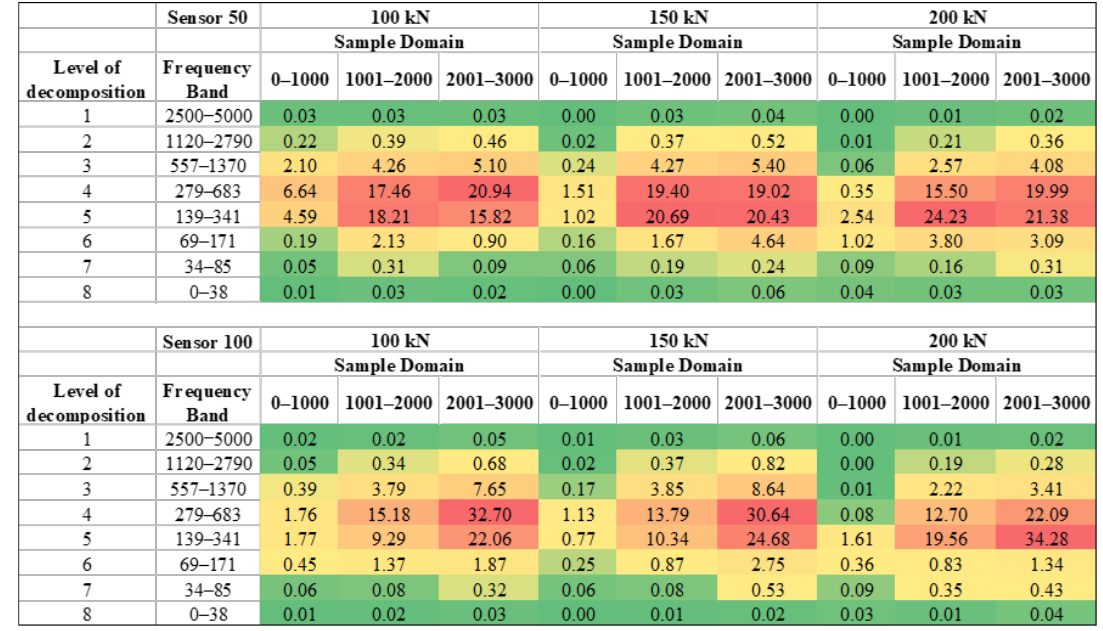
Figure 16. Continuous wavelets transform of AE signals at both sensors.